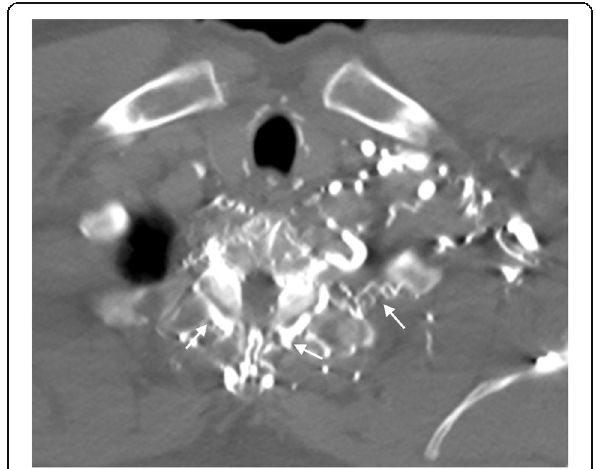
Fig. 6 Posterior neck collaterals. Axial CT image showing extensive unnamed vertebral collaterals (arrows) in a patient with occlusion of the left brachiocephalic vein